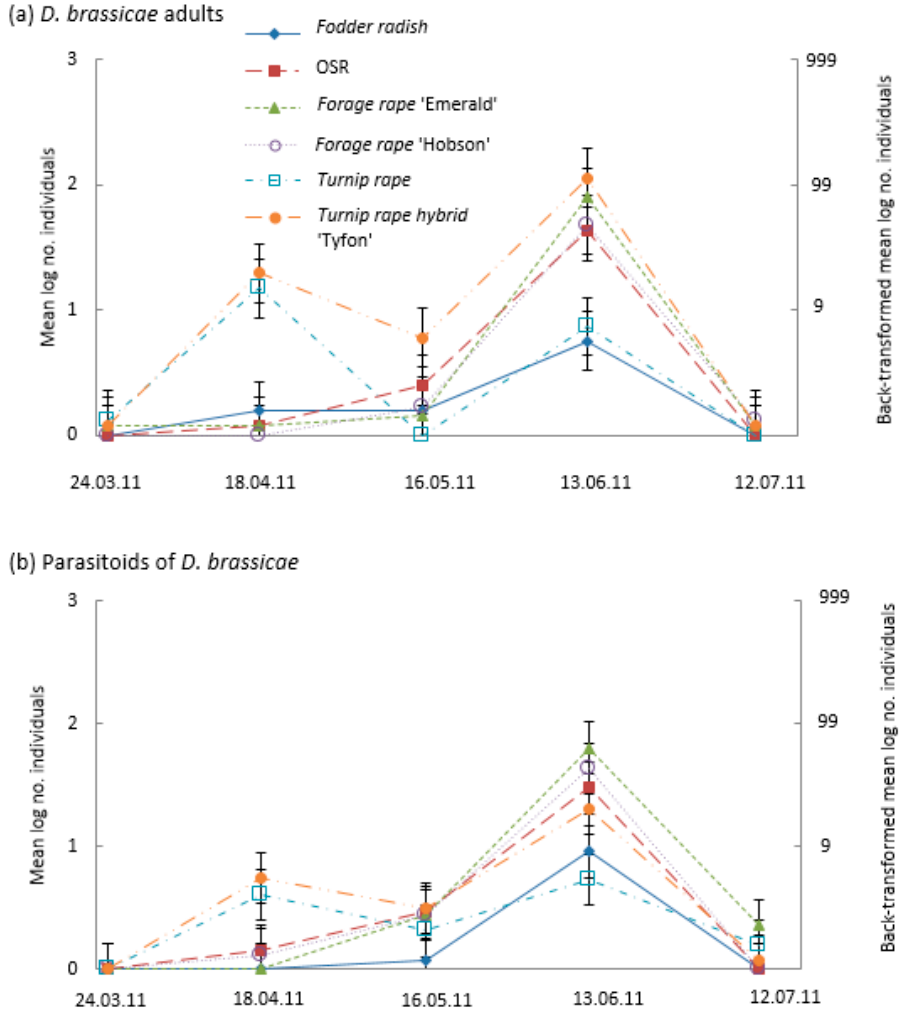
Figure 4. Mean (log scale—left axis and back-transformed -right axis) numbers of Brassica pod midge ( Dasineura brassicae ) ( a ) adults and ( b ) parasitoids in suction samples taken monthly from plots ( n = 4) of different Brassicaceae: Fodder radish ( Raphanus sativus ) cv Apoll; Oilseed rape (OSR, Brassica napus ) cv Castille; Forage rape ( Brassica napus ) cv Emerald and cv Hobson; Turnip rape ( Brassica rapa ) cv Jupiter and Tyfon (a hybrid of B. rapa Rapifer group × B. rapa Pekinensis group). CIs (vertical bars) are valid for within-date comparisons; for between-date comparisons, CIs should be based on SEM values of ( a ) 0.1169 and ( b ) 0.0974.